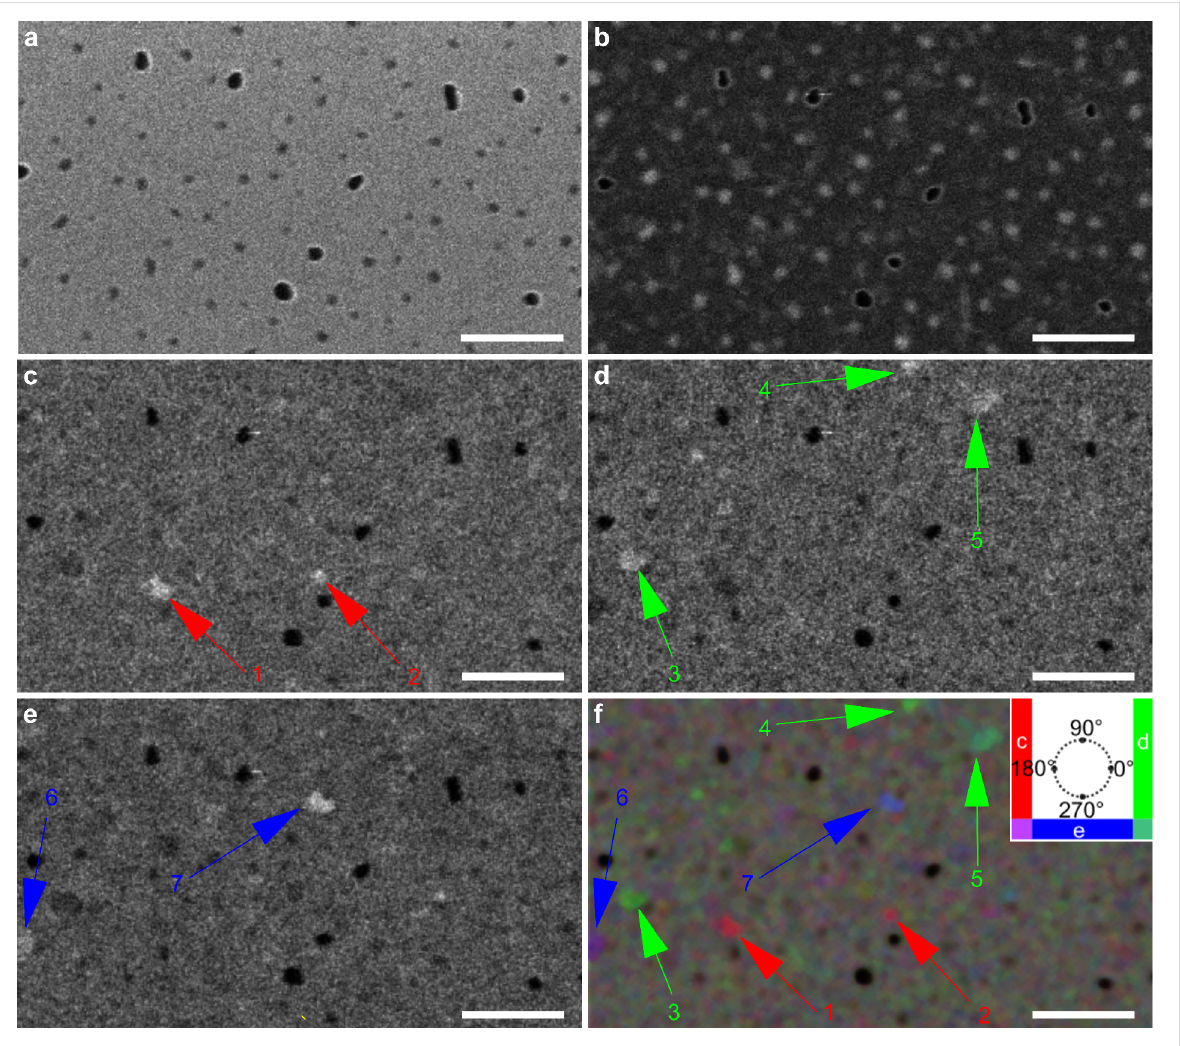
Figure 4: Helium ion microscopy images of the nanoporous polycrystalline silicon membrane. (a) SE image. (b) BF STIM image with polar angle θ < 3° and ϕ from 0 to 360°. Post-processed DF images with polar angle θ > 6° and azimuthal angle ϕ from (c) 135 to 225°, (d) 315 to 45°, (e) 225 to 315°. (f) Composite colored image using (c), (d), and (e) as RGB color channels. The inset shows the color mapping used in Figure 6f for the areas on the detector. The scale bars are 250 nm. The pixel dwell time used in the STIM data acquisition was 200 μ s.